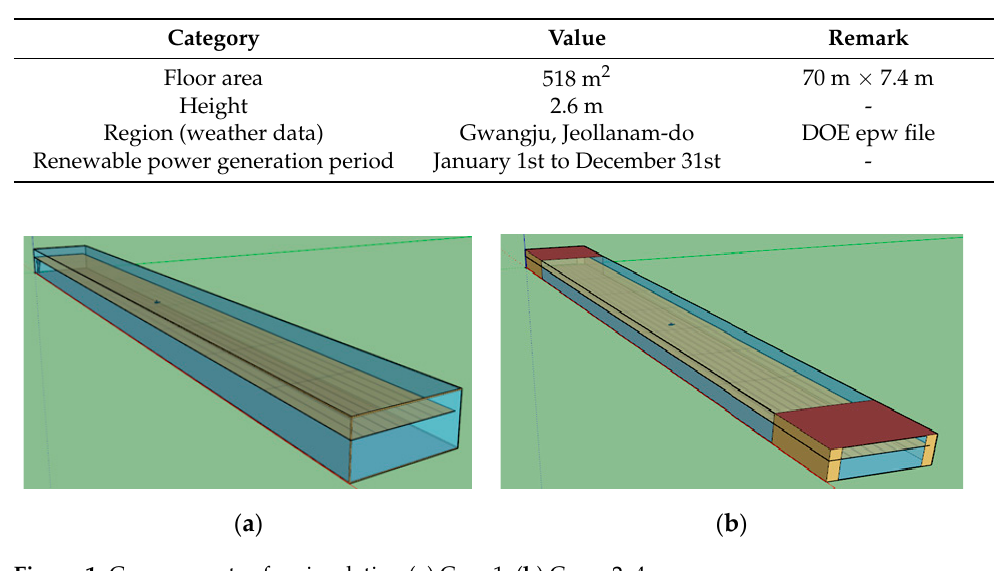
Table 2. Greenhouse overview.